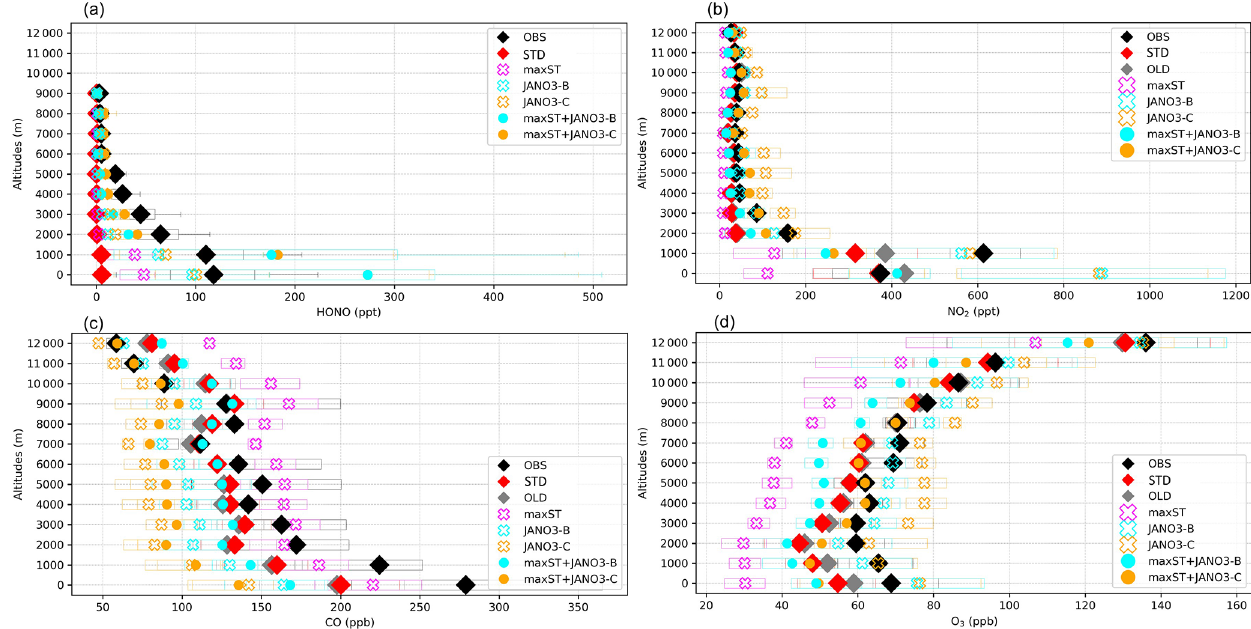
Figure 2. Vertical profiles of (a) HONO, (b) NO 2 , (c) CO, and (d) O 3 measured in the EMeRGe campaign and calculated in the sensi- tivity runs. Diamonds (for OBS, STD, OLD), batches (for maxST, JANO3-B, JANO3-C cases), and filled circles (for maxST + JANO3-B, maxST + JANO3-C cases) show mean vertical concentrations, and the corresponding boxes indicate 25th–75th percentile value ranges. In panel (a) , whiskers with two caps show minimum and maximum HONO levels; all sensitivity runs are shown except OLD (the case without HONO chemistry). In all plots, black is for observation (OBS), colours are for simulations: STD (red), OLD (grey), maxST (magenta),